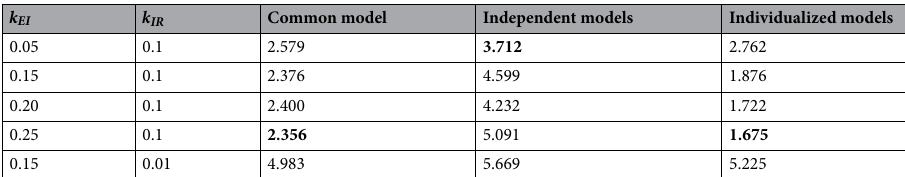
Table 3. Average NRMSE for different values of parameters k EI and k IR parameters. The lowest error for each modelling approach is shown in bold. The lowest error overall was achieved for the individualized approach for k EI = 0.25 and k IR = 0.1 .